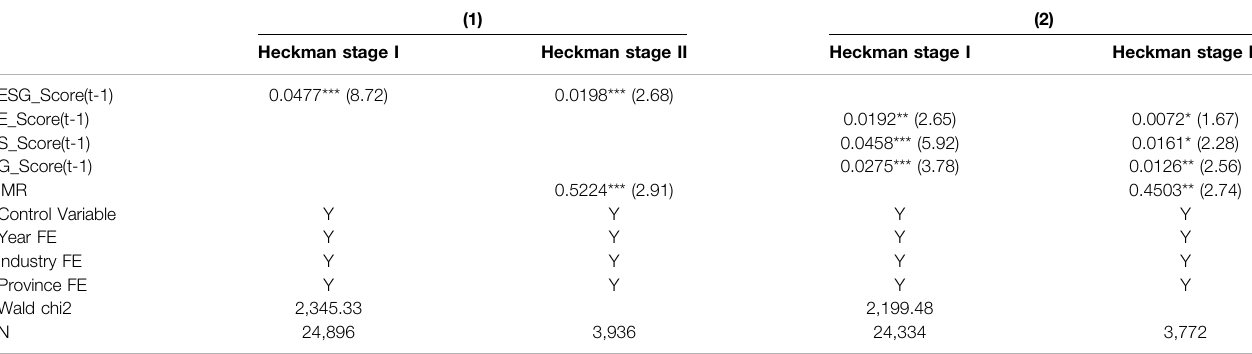
TABLE 5 | Heckman two-step regression results.